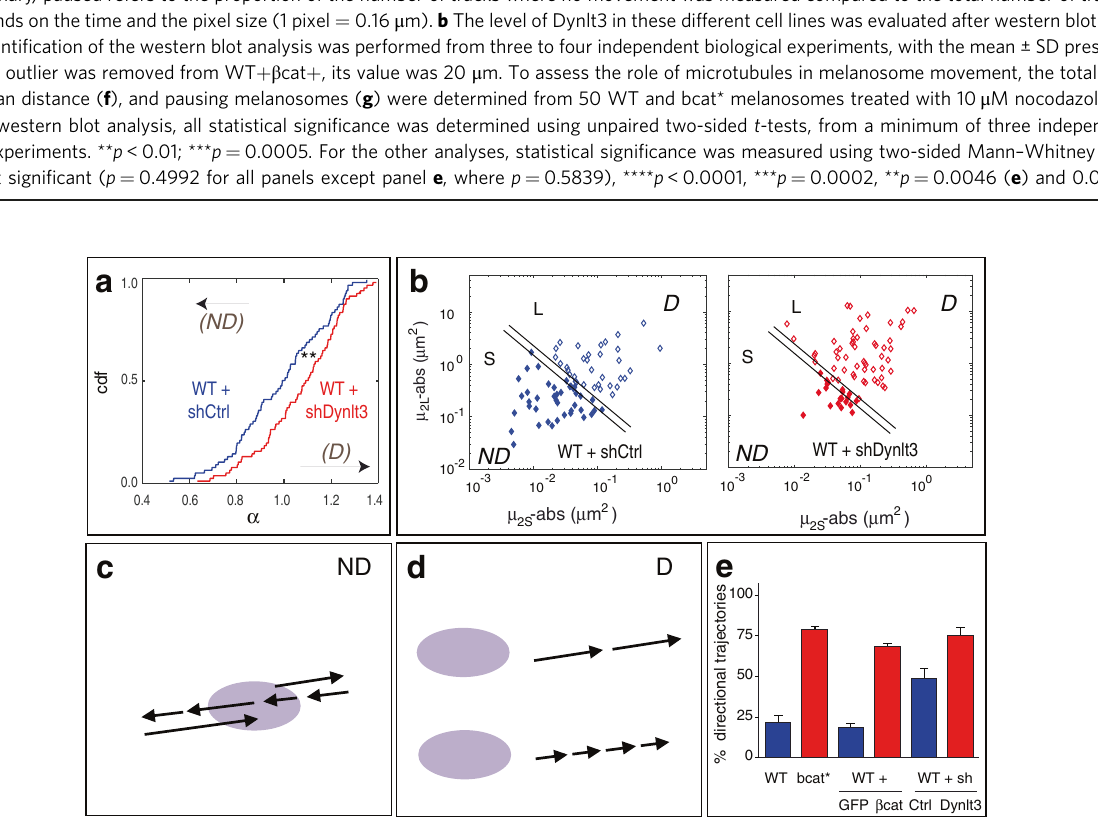
Fig. 6 Increased directional movement of melanosomes in cells with increased levels of β -catenin or decreased Dynlt3. a α distributions for WT-shCtrl (blue) and WT-shDynlt3 (red) populations of trajectories. Non-directional (ND) and directional (D). Statistical analyses were done using a Wilcoxon